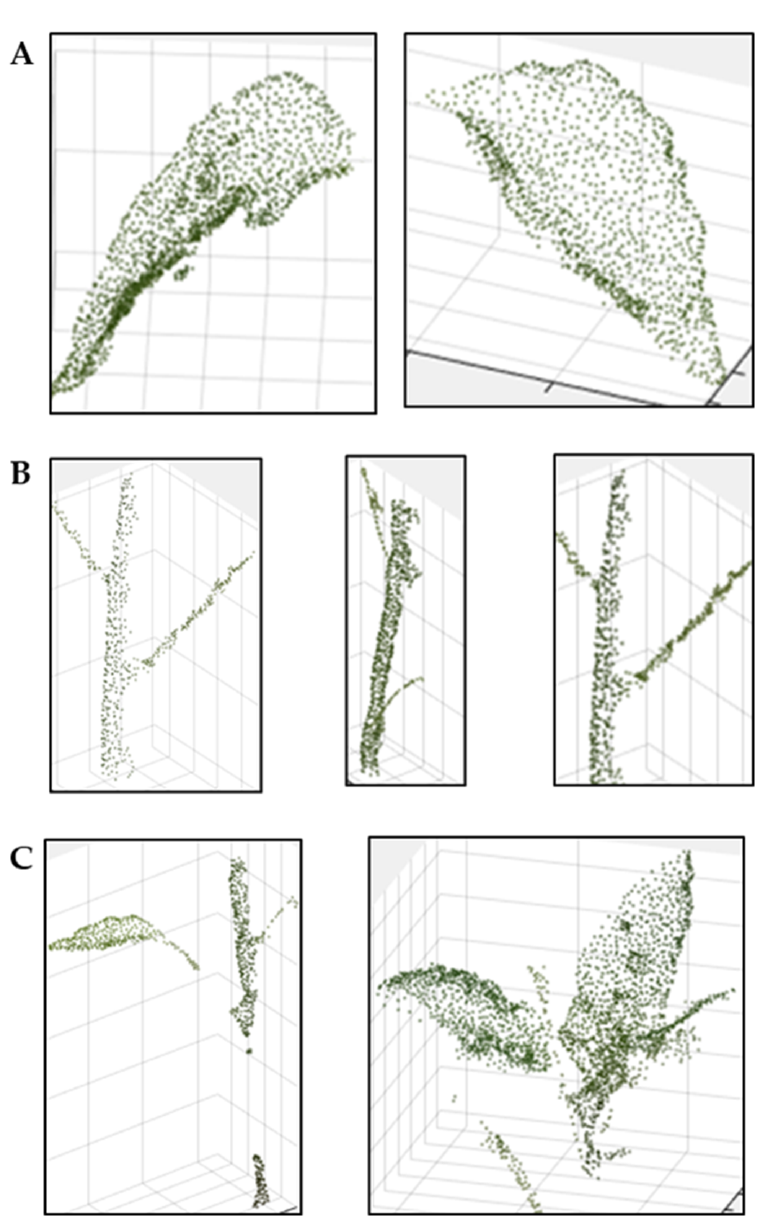
Figure 12. 3D point cloud that is divided: ( A ) leaves, ( B ) stem, internode, nodes; and ( C ) elements that failed to segment.